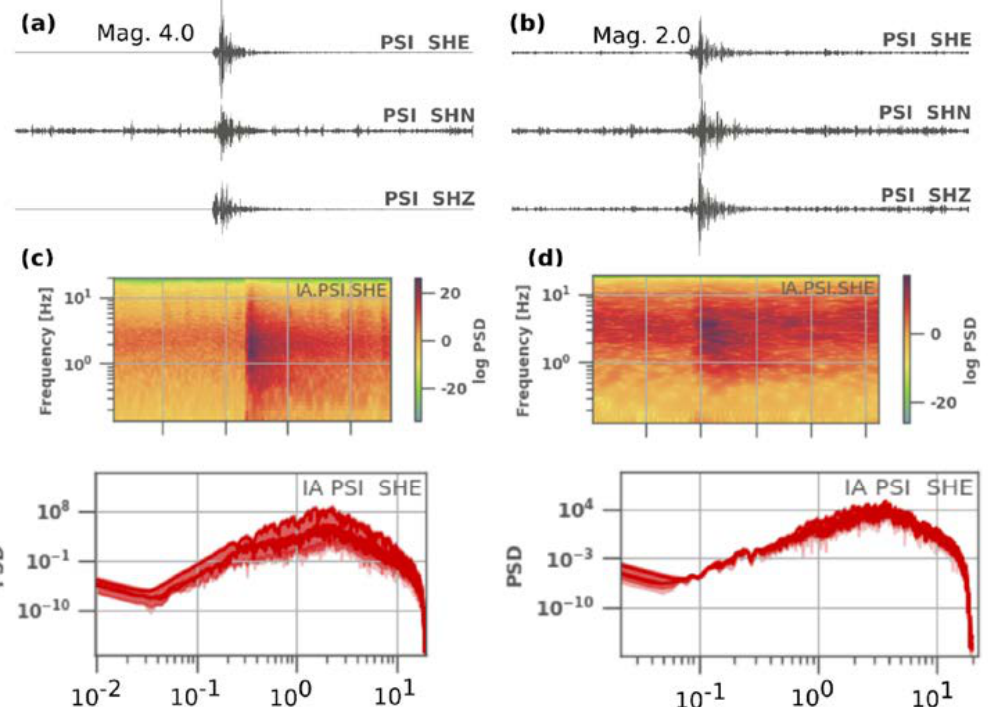
Fig. 4: (a) Example recordings of nonswarm and (b) swarm earthquakes. (c) Example spectrograms and power spectral densities (PSDs) of nonswarm (BOTTOM LEF and swarm (BOTTOM RIGHT) earthquakes. The spectrogram shows that the swarm earthquake has more high‐frequency content than the nonswarm earthquake.